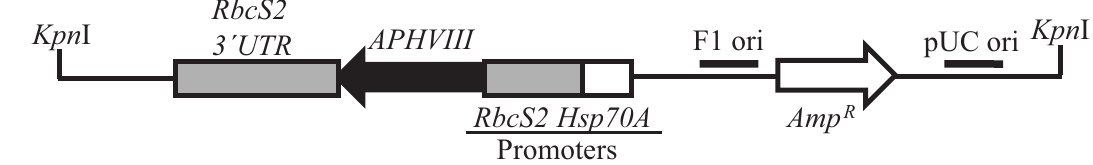
Figure 2. Linearized pBC1 plasmid used for random insertional mutagenesis. The cleavage site of Kpn 1 restriction enzyme, used for linearization of the vector is shown. APHVIII is under the control of combo promoters which consist of the promoter of the gene encoding the small subunit of Rubisco (RbcS2) and the gene encoding the heat shock protein 70A (Hsp70A). pBC1 is a phagemid and its F1 origin (F1 ori) and pUC origin (pUC ori) are shown. The size of the plasmid is 4763